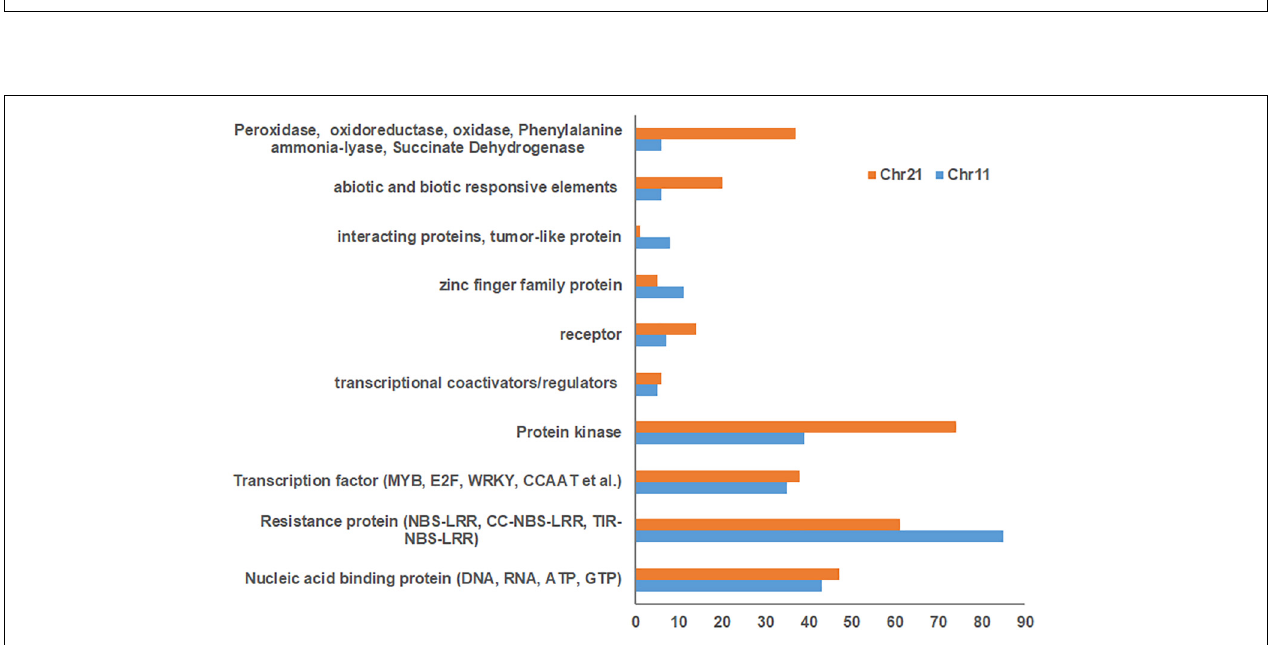
FIGURE 2 | Comparison of number of stress response elements on Chr 11 BACs with those on Chr 21 BACs based on Gossypium hirsutum Unigene NCBI database.